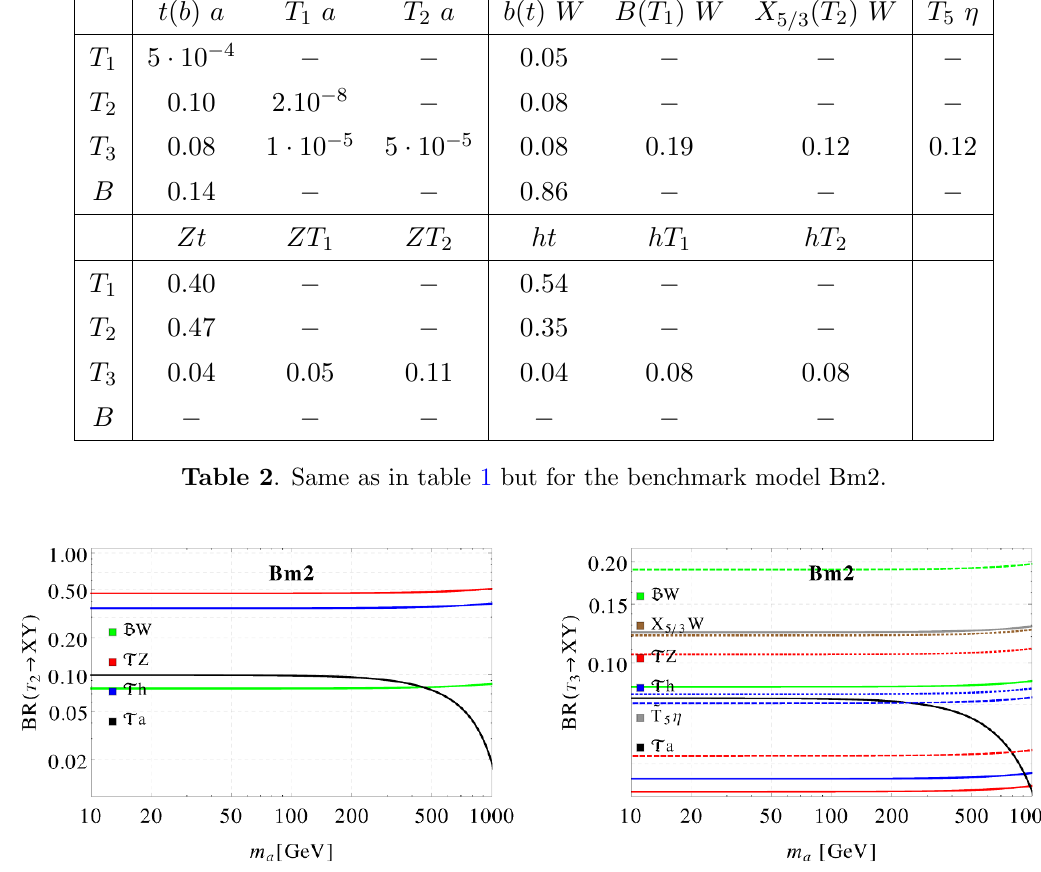
Figure 7 . Branching ratios for heavier T 2 ; 3 VLQs as a function of the mass m a in the benchmark model Bm2 de(cid:12)ned in eqs. (3.16) and (3.17). The continuous, dashed and dotted lines correspond respectively to T = f t; T 1 ; T 2 g or B = f b; B g